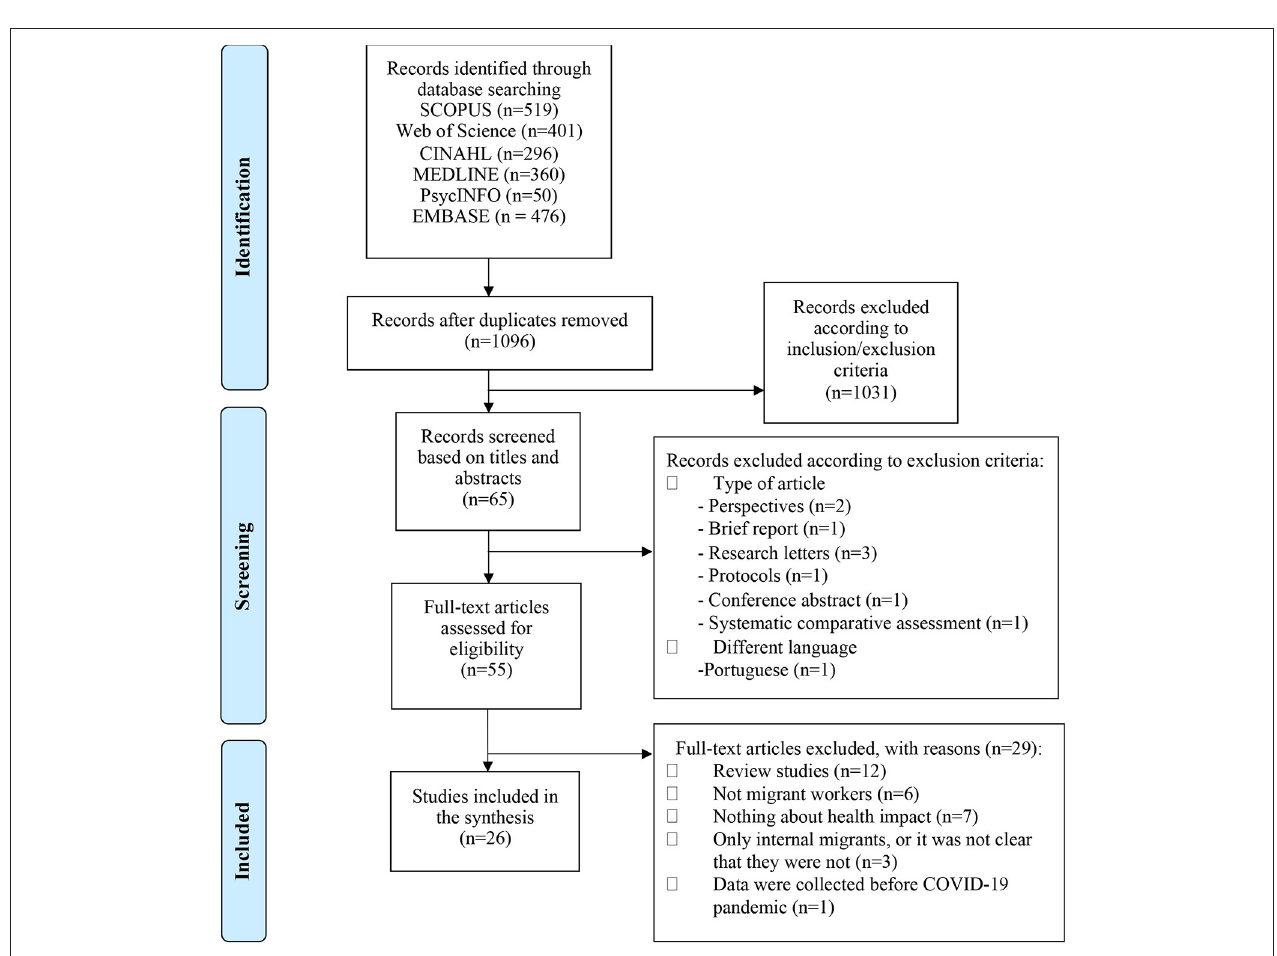
FIGURE 1 | PRISMA